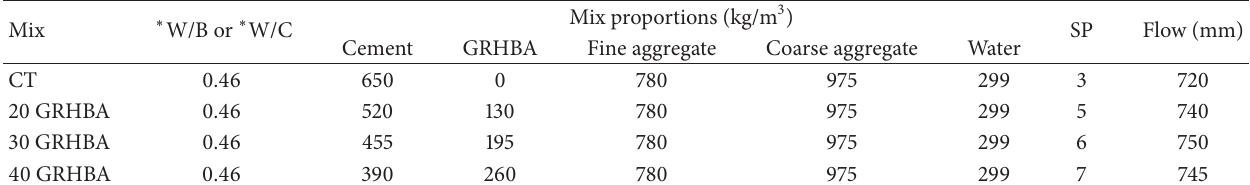
Table 3: Self-compacting concrete mixture proportions.